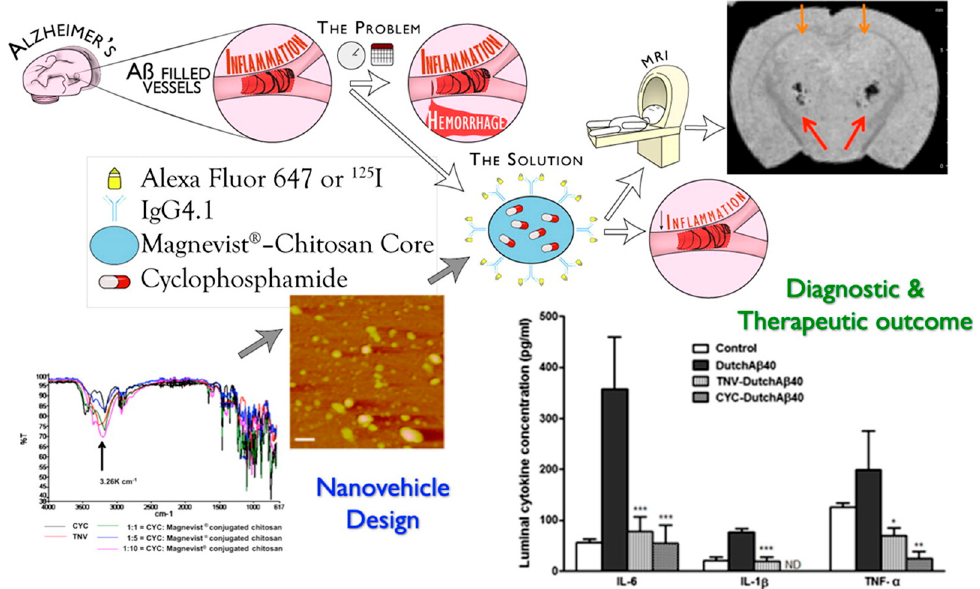
Figure 4. Effectiveness of theranostic nanovehicles based on CH ‐ Magnevist ® in targeting cerebrovascular amyloid deposits. * p < 0.05, ** p < 0.01, *** p < 0.001. Reproduced with permission from [46]. Elsevier